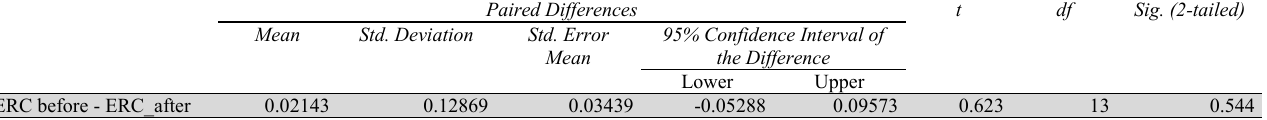
Test Results for the Mean Difference of Two Paired Samples